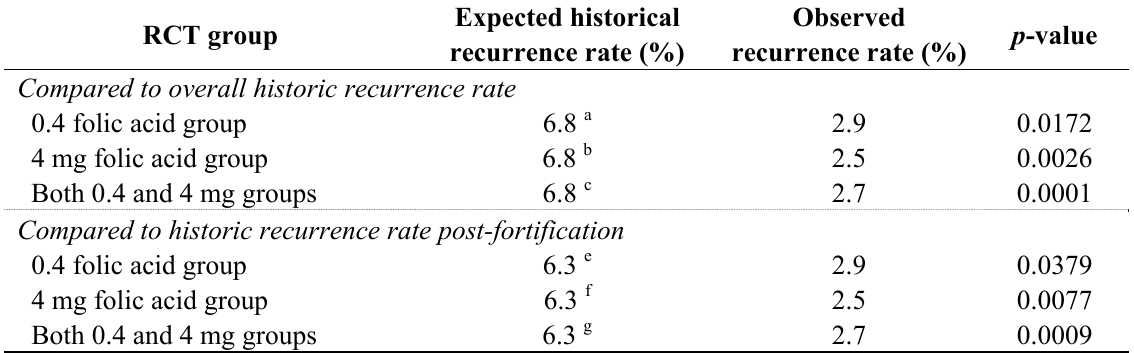
Table 4. Expected versus observed recurrence rates in OCPP.